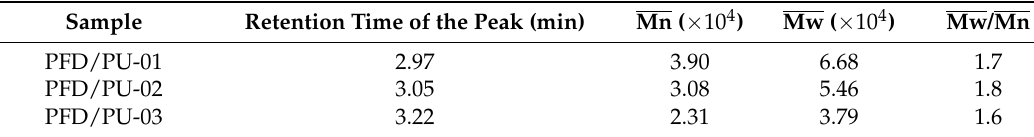
Table 2. Gel permeation chromatography (GPC) results of PFD/PUs.